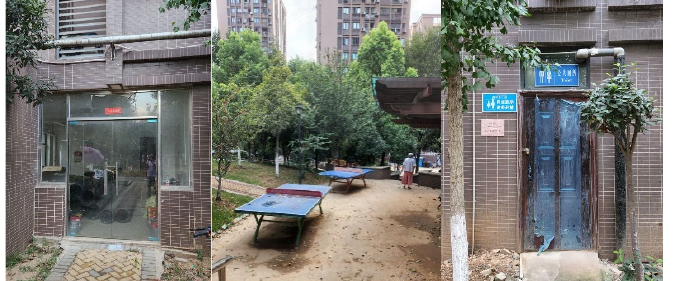
Figure 10. The vacant or blocked elderly activity room, toilets, and ping ‐ pong tables in Qingheju neighbourhood.